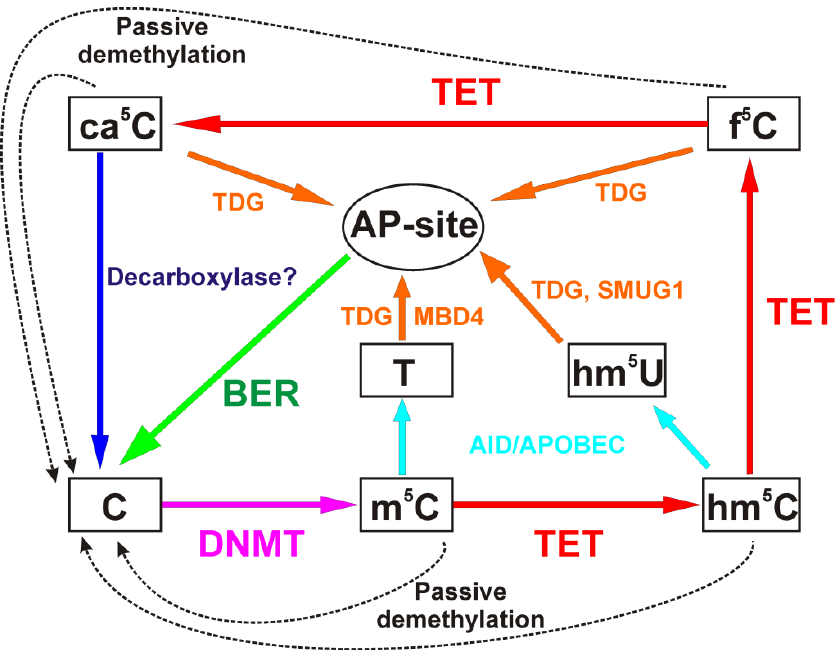
Figure 4. A diagram of active and passive cytosine demethylation pathways during epigenetic regulation. m 5 C residues are deaminated and oxidized thereby yielding uracil derivatives and oxidized m 5 C derivatives, which are removed by DNA glycosylases TDG, SMUG1, and MBD4 in BER [115].